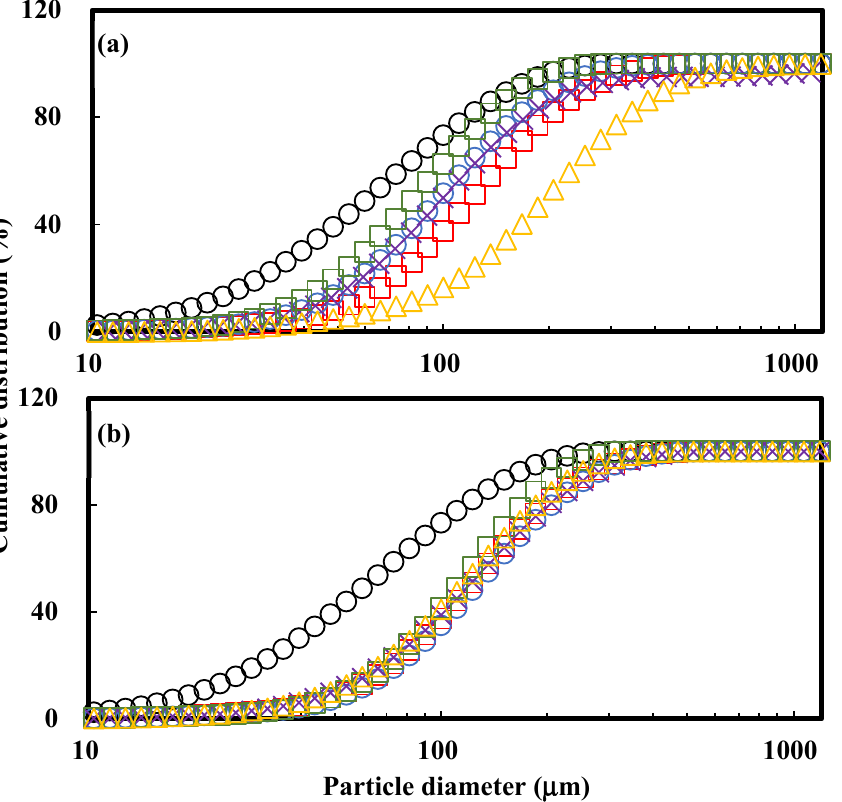
) and agglomerated MPIPs with various sugar binders at (cid:35)